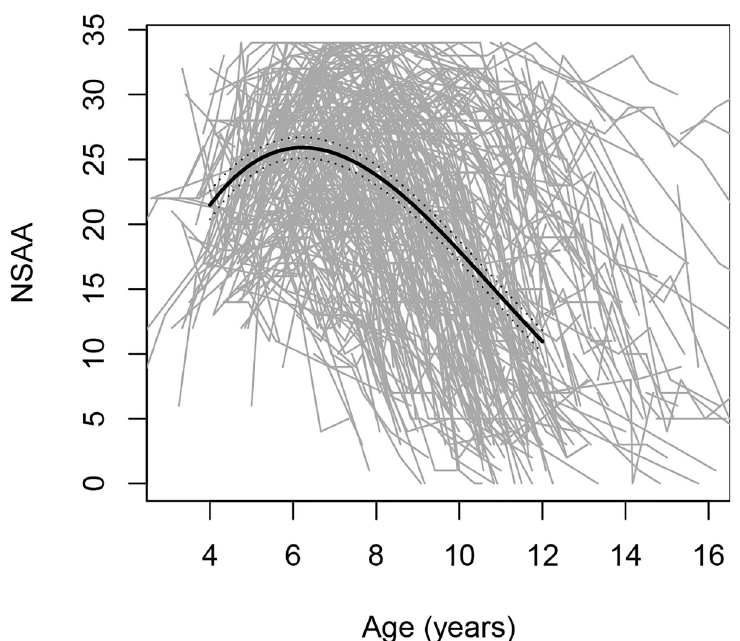
Fig 1. NSAA total score trajectories for individual patients by age (in grey) and the fitted mean and 95% confidence interval (in black). Each grey line represents NSAA total scores from an individual patient plotted versus age; the population mean and its 95% confidence bands are shown in black. NSAA, North Star Ambulatory Assessment.